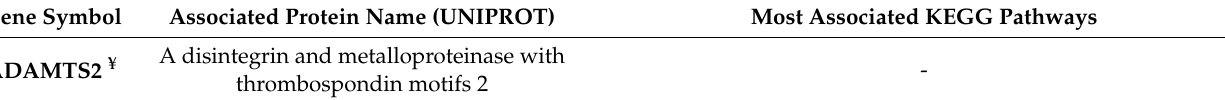
Table 1. Hypergeometric test results on the intersection of DEGs of datasets found by DESeq2. VS p -Val (Hyper) Overlap RO-MT 0.00054 128 2885 477 14,001 MC-RO 0.00516 347 2885 1515 14,186 MT-MC 98 477